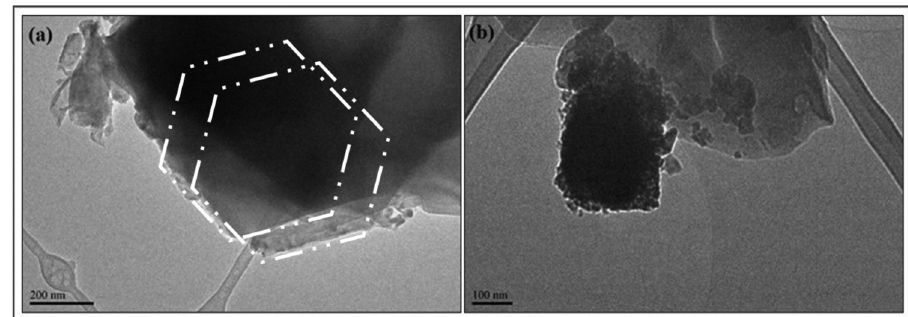
Figure 3: TEM micrographs of aggregates A ( a ) and B ( b )